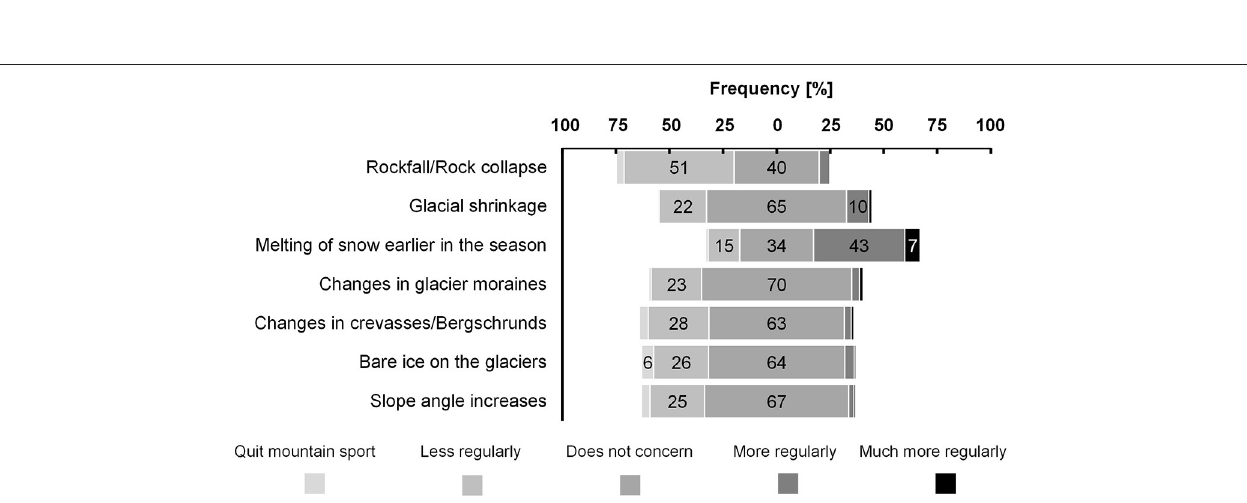
Frontiers in Public Health |